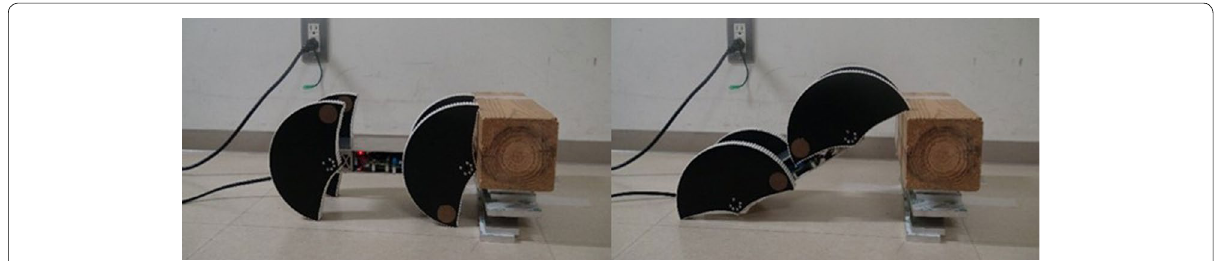
wheel during turning. The horizontal axis is time and the vertical axis is angular velocity. The blue graph shows the change in the phase of the wheel when it is moving straight forward and the red graph shows the change in the phase of the wheels when turning. In the graph, the slow angular velocity is the contact with the ground; the fast one is the liner side of the semicircular wheel. Time on the ground is increased by making the time of the liner side faster and overlapping with other wheels; it can make a different mov- ing speed of the left and the right wheels. However, because the rotation angles of one cycle are the same on both sides, slow rotation of the wheel can be reproduced. Also, the liner side time gets faster. Construction of turning motion Equations (2), (3) is the formula that forms the basis of the turning motion. θ R and θ L are the sum angle of the wheels of both sides in one cycle.